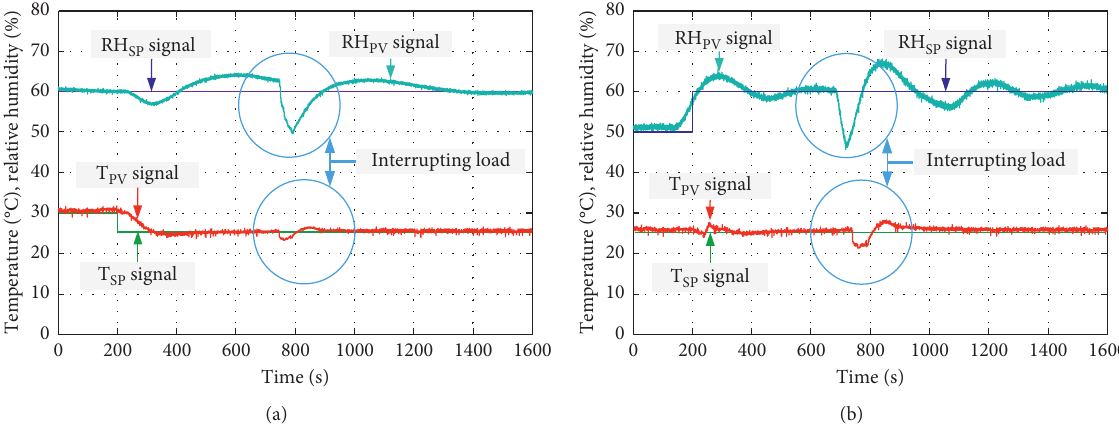
Figure 16: The process response results during load interruption. (a) Downward temperature setpoint ( ° C). (b) Upward RH setpoint (%).